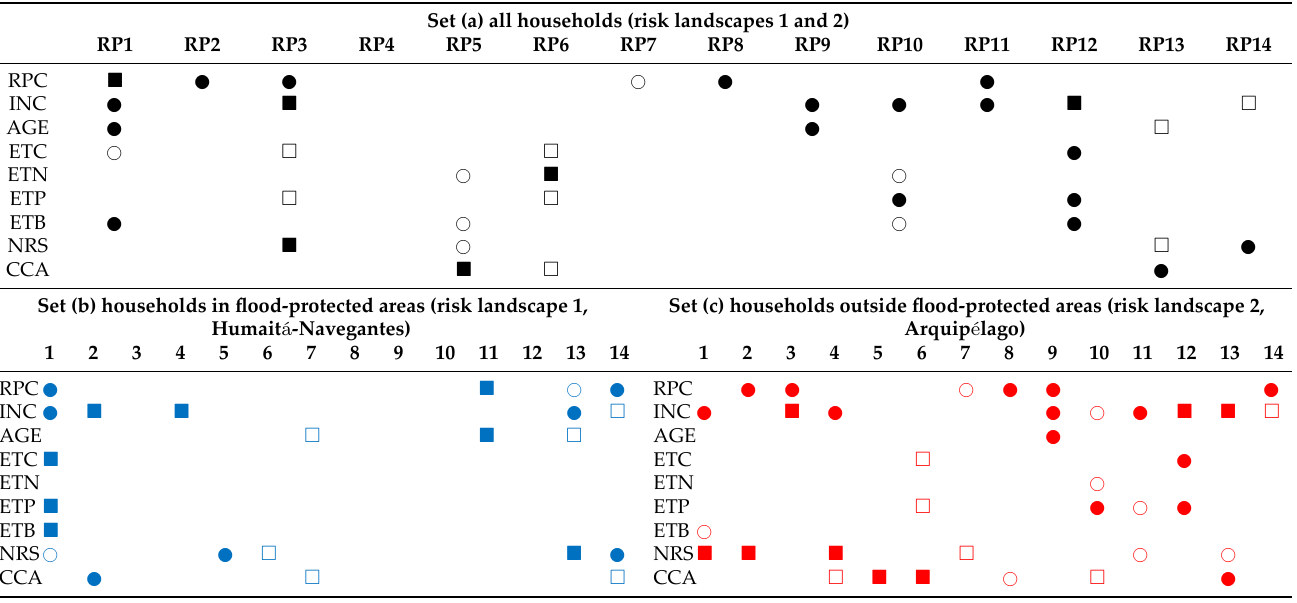
Table 7. Synthesis of regression models for risk response and risk perception for sets: (a) all residents (risk landscapes 1 and 2), (b) residents in flood‑protected areas (risk landscape 1, Hu‑ mait á ‑Navegantes), and (c) residents outside flood‑protected areas (risk landscape 2, Arquip é lago) . Acronyms follow the definitions in Table 1.